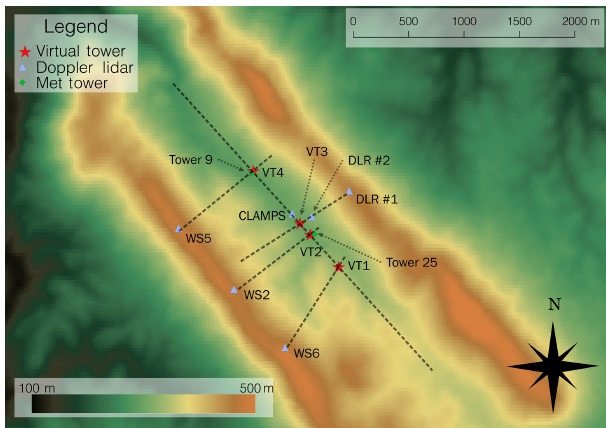
Figure 1. Map of DLs, meteorological towers, and virtual towers at the Perdigão site. The color fill corresponds to the height of the terrain above sea level, red stars are virtual-tower locations, blue triangles are DL locations, and green diamonds are instrumented meteorological towers. Tower 9 is a 60m tower and Tower 25 is a 100m tower. CLAMPS was located at the Orange Grove